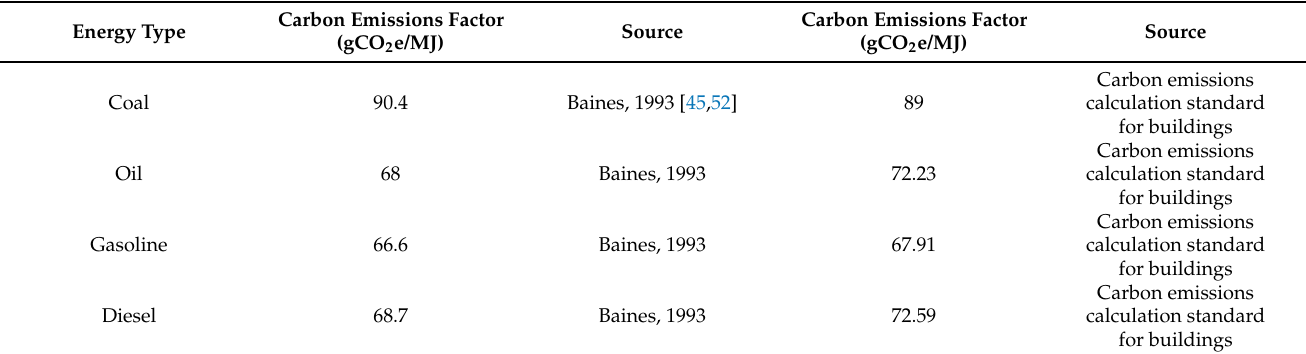
Table 4. Construction material waste factors and carbon emissions